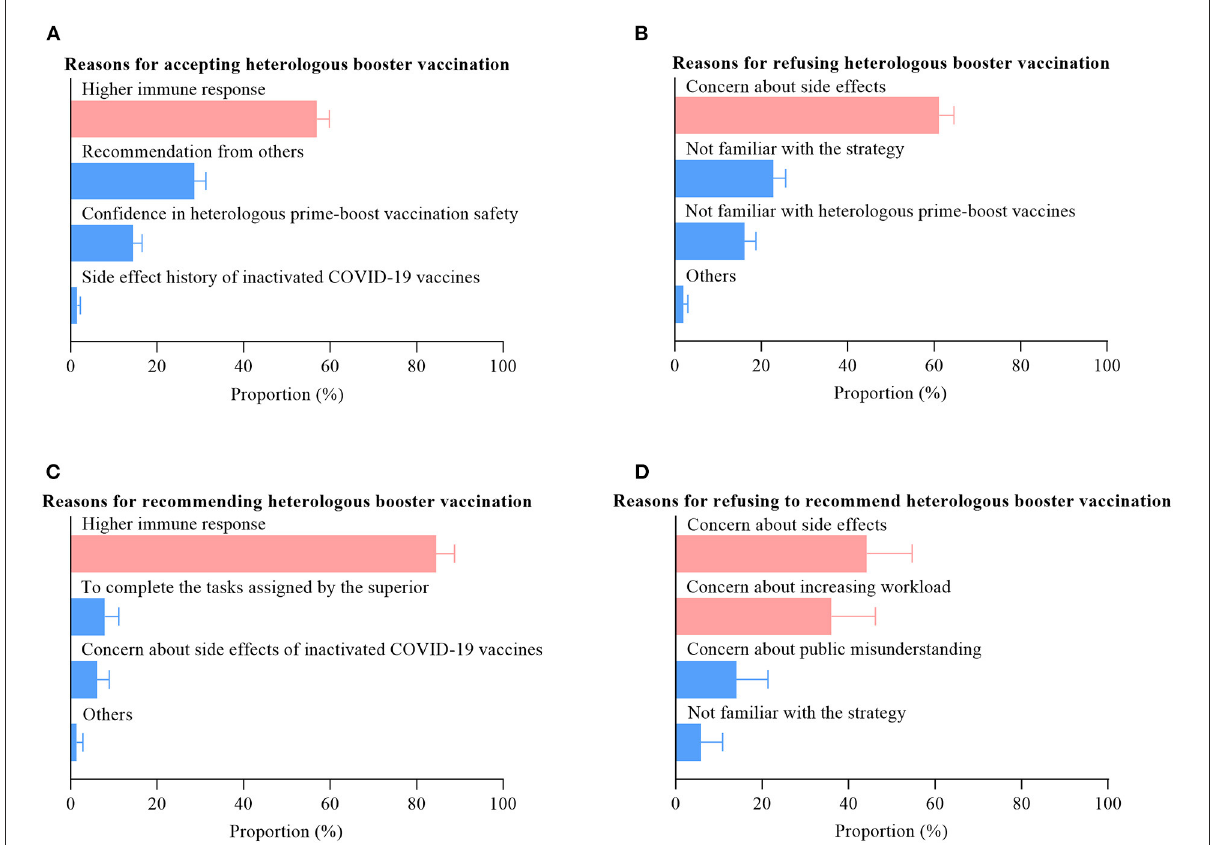
FIGURE2 Reasons for accepting or refusing heterologous booster